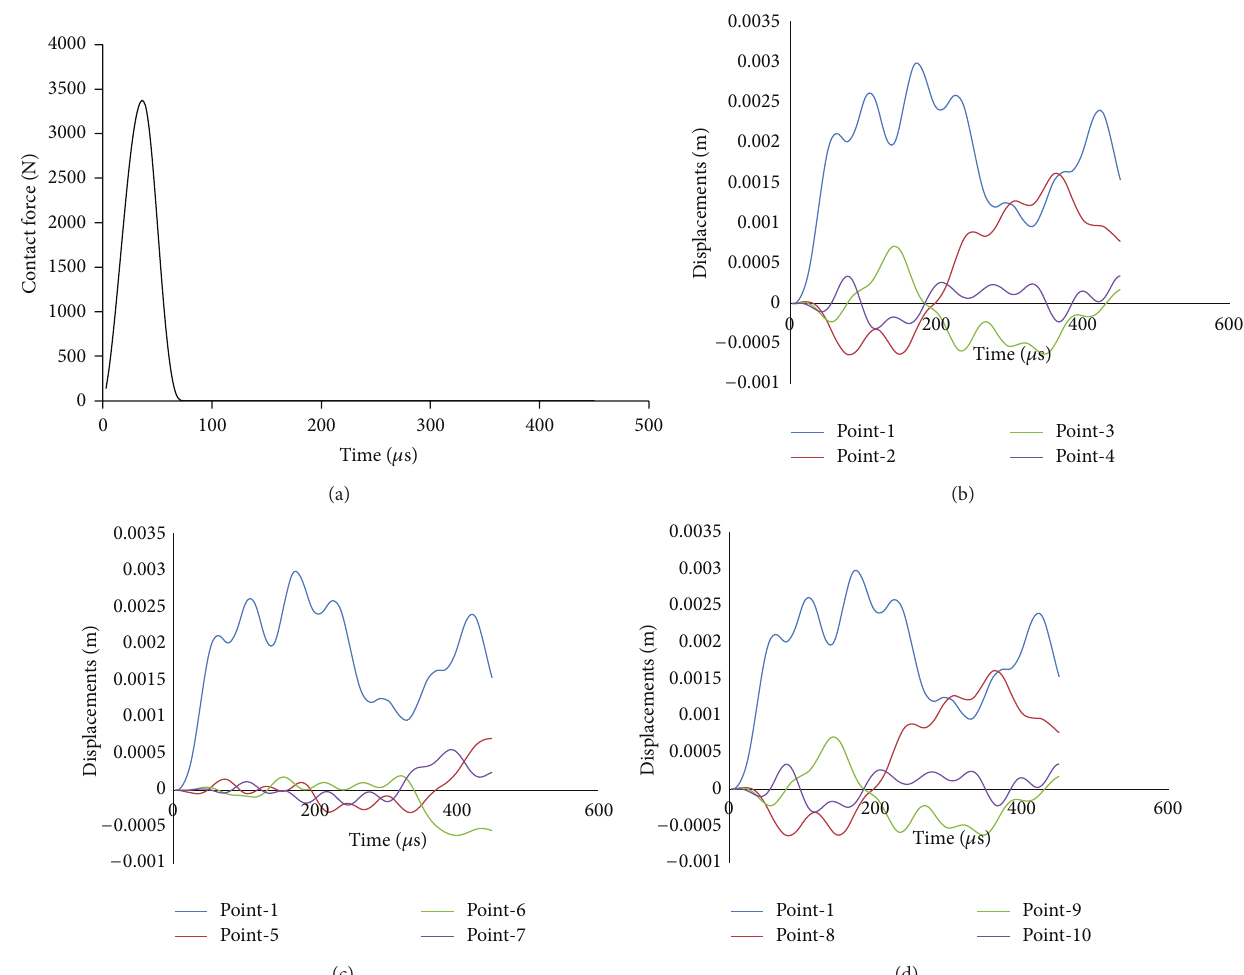
Figure 8: Impact response of clamped cross ply (CL/CP) composite hypar shells for impact velocity 7